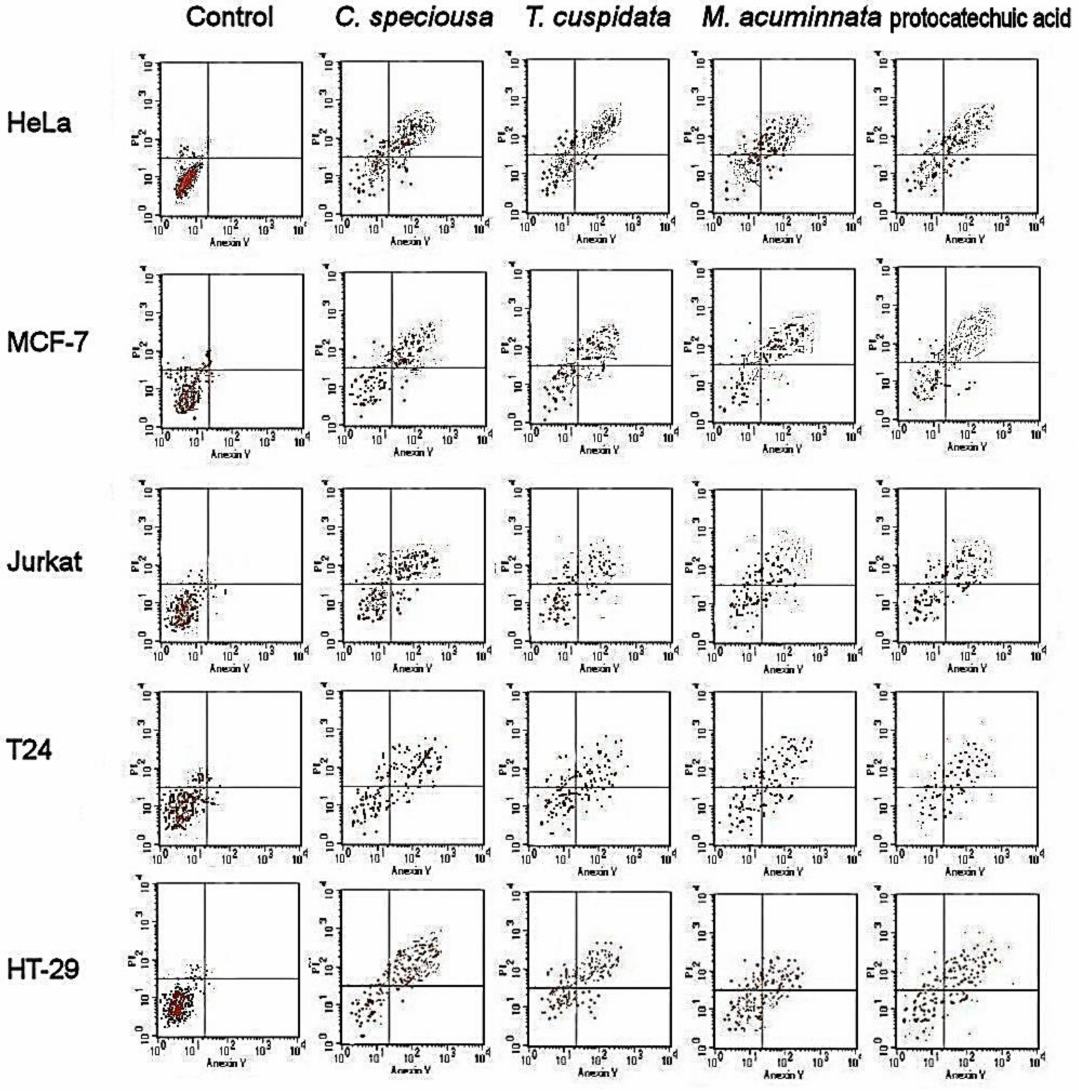
Figure 1. Cellular apoptosis induced in cancer cells at 24 h following treatment with bark extracts and catechin. Lower left, viable cells; upper left, necrotic cells; lower right, early apoptotic cells; and upper right, late apoptotic